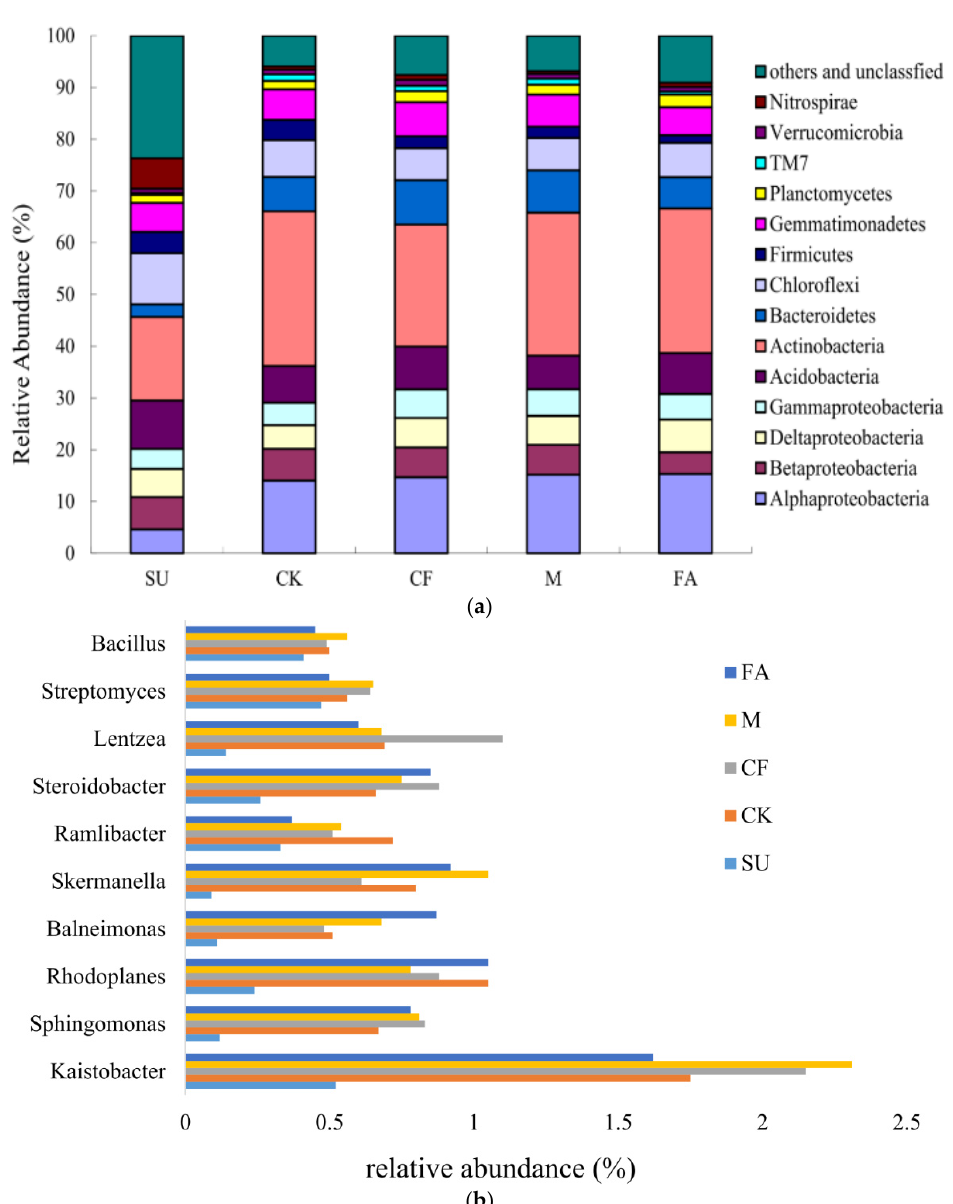
Figure 2. ( a ) Relative abundance of the dominant bacteria phyla (top 10) in all different treatments; ( b ) relative abundance of the dominant bacteria genera (top 10) in all different treatments. Relative abundances (>1%) are based on the proportional frequencies of those DNA sequences that could be classified at the phylum (proteobacterial class) level. Sequences not classified to any known phylum and phylogenetic groups accounting for ≤ 1% of all classified sequences are summarized in the artificial group “others and unclassified”. CK: reclaimed soil sampled in no-fertilizer treatment; CF: reclaimed soil sampled in chemical fertilizer treatment; M: reclaimed soil sampled in manure treatment. SU: subsided soil sampled in an adjacent site; FA: soil sampled in another adjacent farmland. TM7: the phylum candidatus Saccharibacteria .